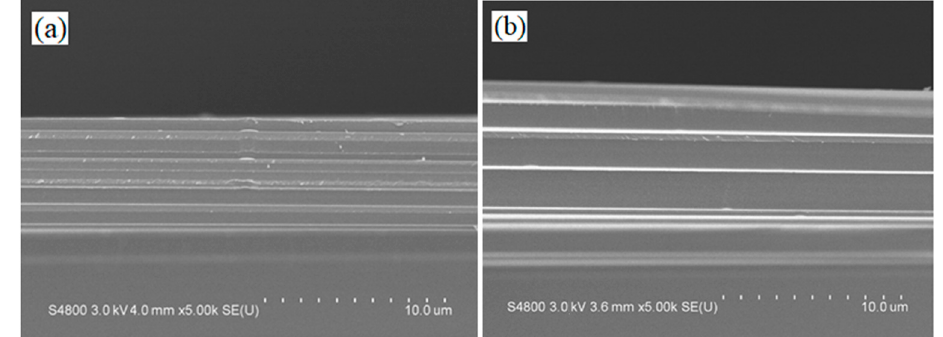
Figure 6. SEM cross-section image of ( a ) 20-layer; ( b ) 23-layer BPFs.